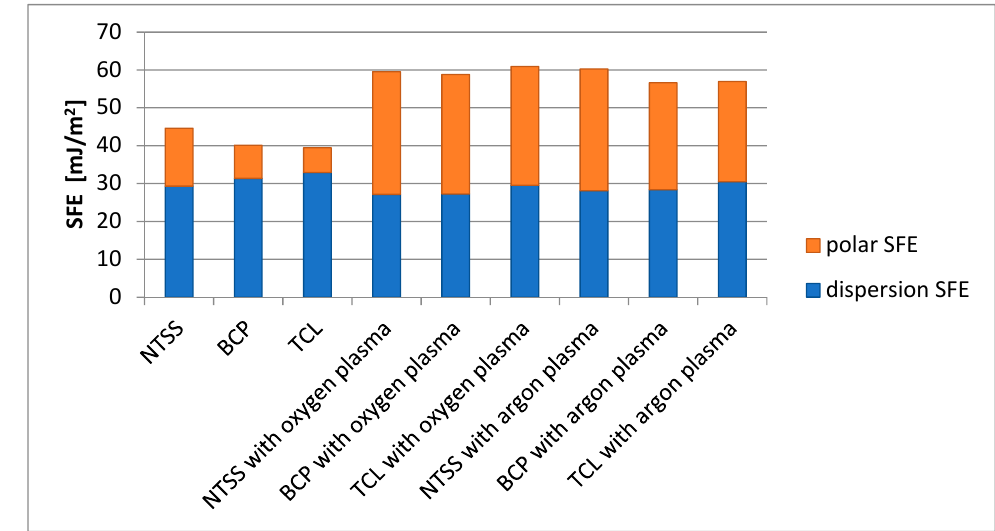
Figure 2. Changes in surface free energy of the film and its components due to plasma activation of the material.